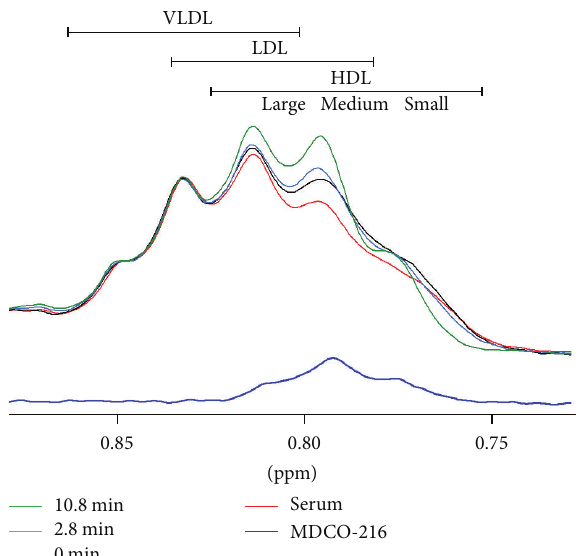
Figure 3: Changes in the 1 NMR lipid methyl signal envelope brought about by incubation of MDCO-216 with serum at 47 ∘ C. The signals shown are from MDCO-216 (dark blue) and the serum specimen (red) before they were mixed together. The digital sum of these 2 signals (black) represents the mixture at “0min” before physical mixing occurs, andtheblueand green curvesarethesignals observed after 2.8 and 10.8 minutes of incubation, respectively. Also the positions in the serum spectrum of the methyl signals from the subclasses of VLDL, LDL, and HDL, with larger subclasses giving rise to signals further to the left [8], are shown at the top.